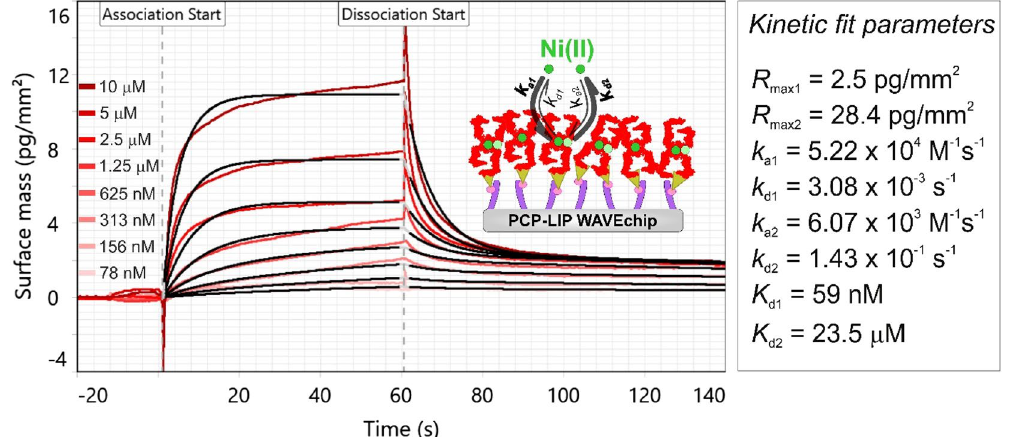
Figure 5. Measured kinetic data of Ni(II) binding obtained at high FliC-NikR C coverage on a PCP-LIP WAVEchip (red curves). The shown measurement curves were adjusted and represent Ch1 - Ch2 reference corrected data. The data were fitted using the heterogeneous ligand kinetic model (black curves). The spikes at association start and dissociation start annotations were originated from solution exchange effect. The inset scheme illustrates the binding of Ni to the FliC-NikR C tetramers which were immobilized on the quasi-planar lipophilic coating of the PCP-LIP chip. While the solid circles with dark green color represent Ni(II) ions bound to the HA sites, the light green circles represent Ni(II) ions bound to the LA sites. Kinetic data determined from the model fit are shown in the right table. Here, subscript index 1 and 2 correspond to the HA and LA sites, respectively, R max is the maximal response value, k a and k d are the association and dissociation rate constants as well as K d is the dissociation